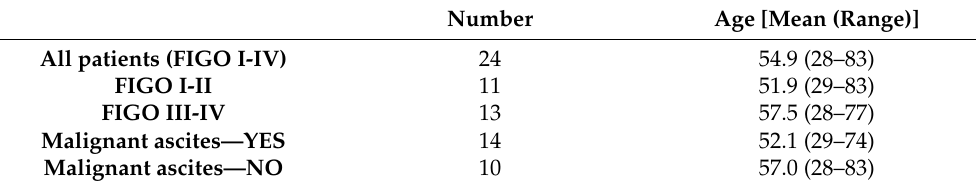
Table 1. Clinical characteristics of ovarian cancer patients included in the study. Number Age [Mean (Range)] All patients (FIGO